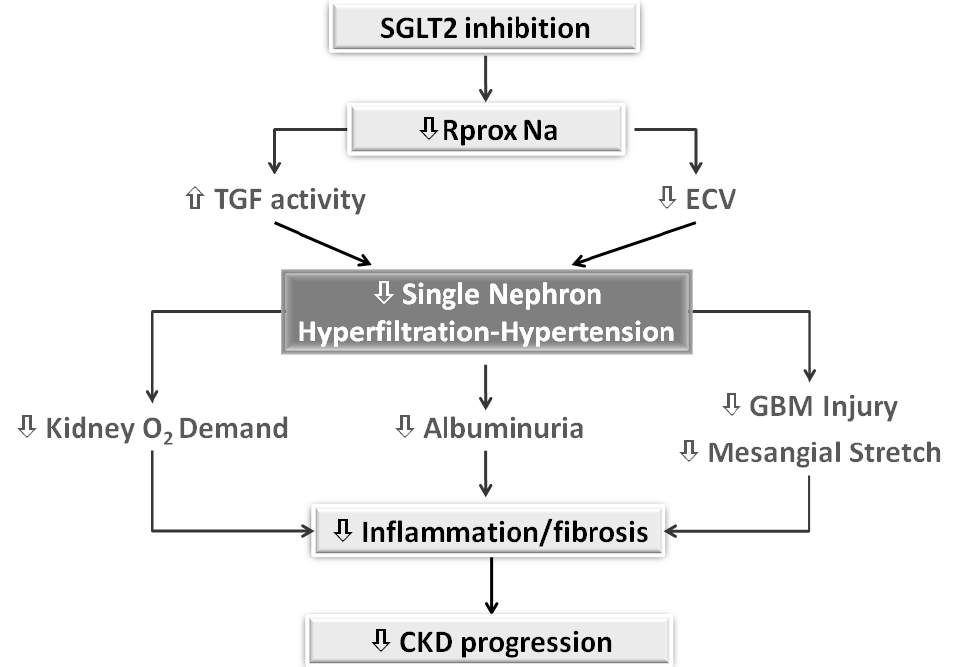
Figure 2. Intrarenal hemodynamic mechanisms of nephroprotection by SGLT2 inhibition. SGLT2, sodium/glucose cotransporter 2; Rprox Na, proximal tubular reabsorption of sodium; TGF,